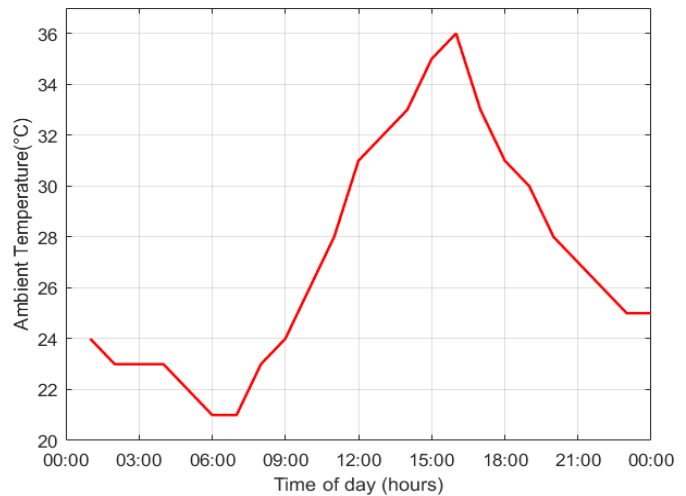
Figure 4. Ambient temperature.